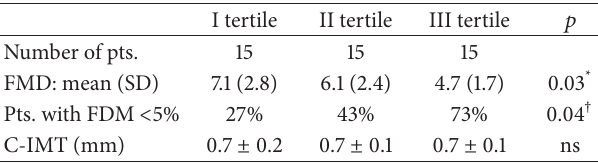
Table 2: FMD value, percentage of patients with a pathological FMD value, and c-IMT in the three tertiles.